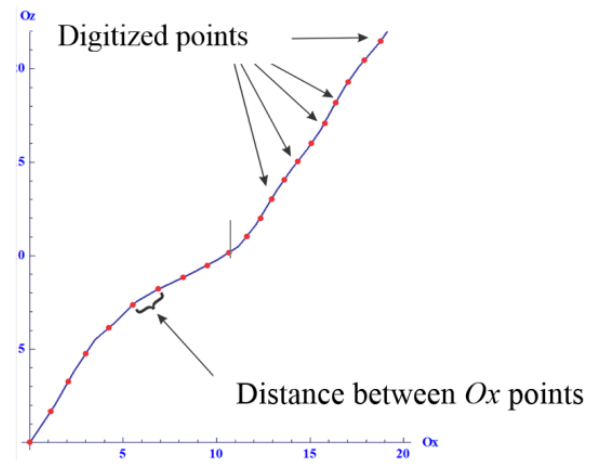
Figure 2. The resulting profile curve based on the scanned points. For each segment [ P m , P m +1 ], the equation in projection on the xOz plan is